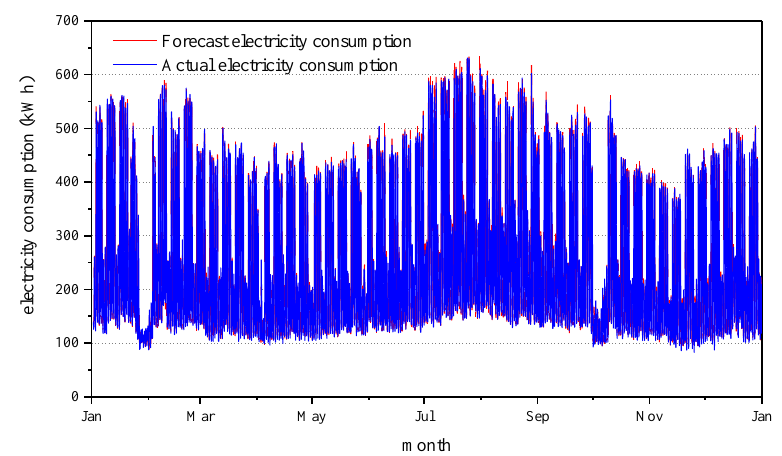
Figure 13. Hourly lighting electricity forecast in 2017. Table 5. Different model prediction indicators result for lighting electricity consumption.